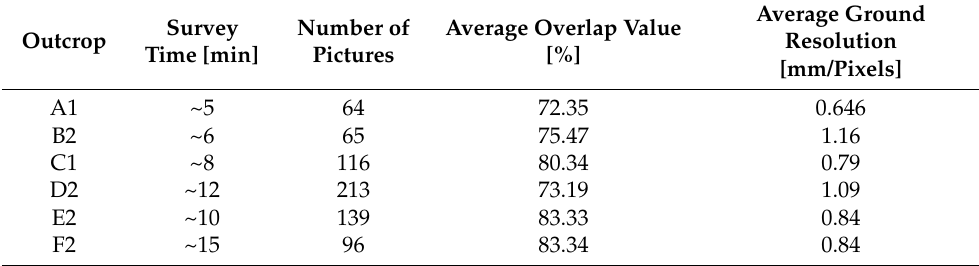
Table 4. Main characteristics of MP